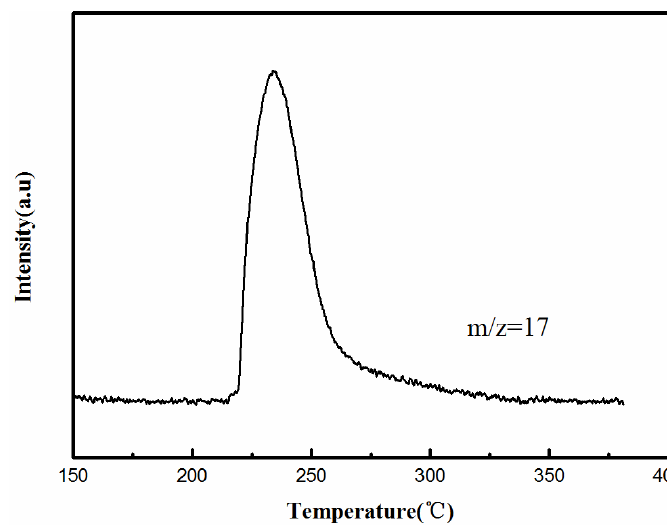
Figure 5. TPD-MS spectra of desorption of crystal A and B.